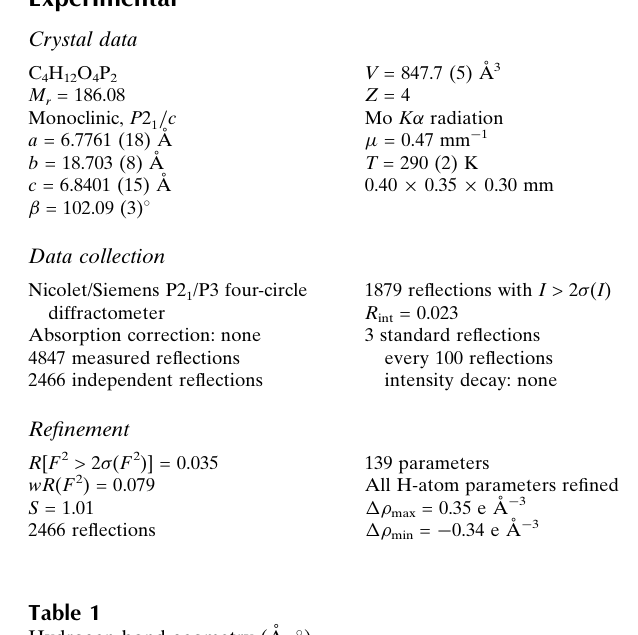
Hydrogen-bond geometry (A˚ , (cid:2)